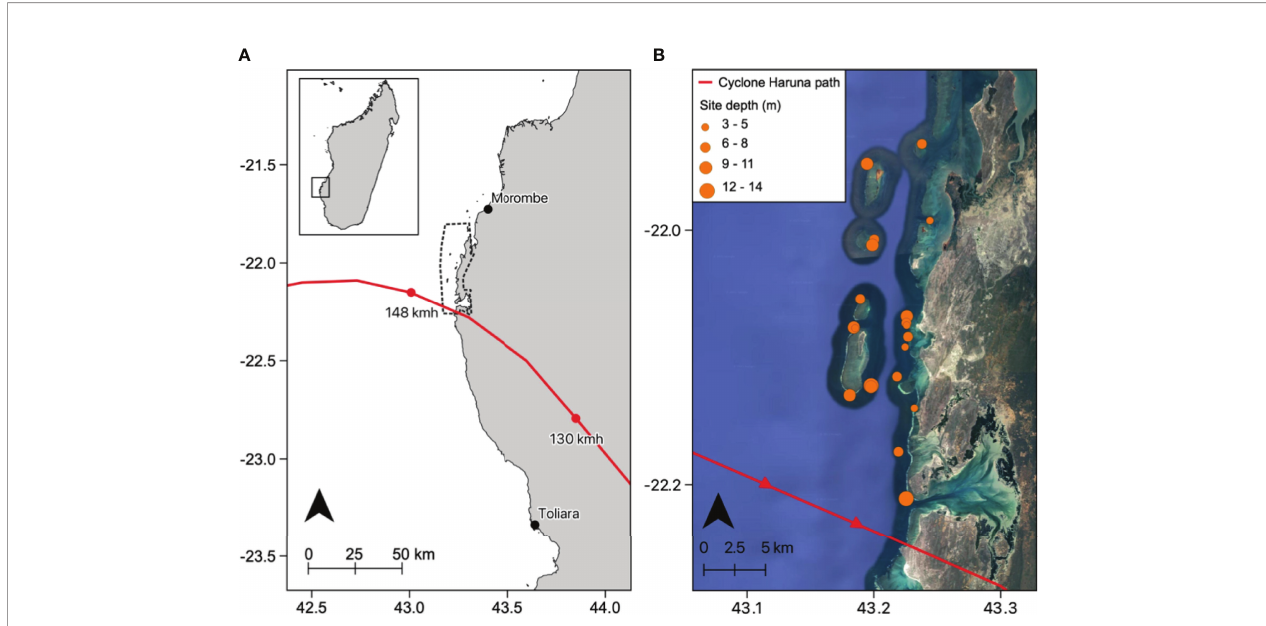
FIGURE 1 | (A) The position of study region in relation to the path of Cyclone Haruna (solid red line) on the 22nd Feb 2013. Dotted line is boundary for the Velondriake Locally Managed Marine Area. (B) The location of reef sites in relation to the path of Cyclone Haruna (solid red line) on satellite image. Reef depth is indicated by the size of the orange